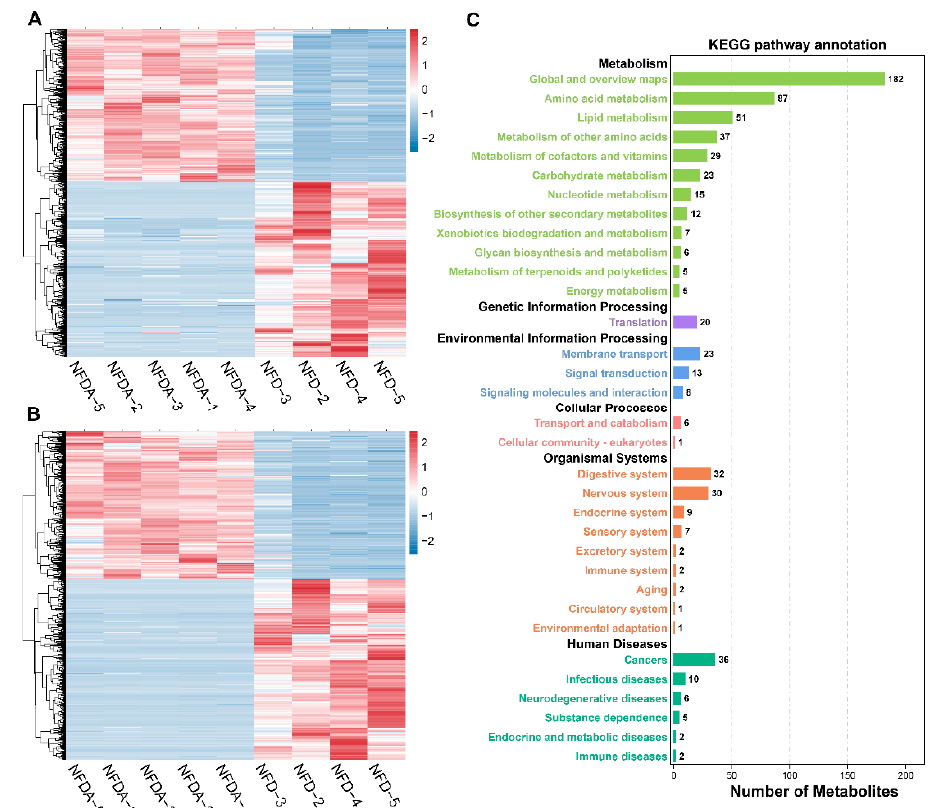
Figure 5. Identification and functional annotation of differential metabolites. ( A ) Clustering heatmap of differential metabolites in positive ion mode. ( B ) Clustering heatmap of differential metabolites in negative ion mode. The red, white and blue colours represent relative abundance from high to low. ( C ) KEGG pathway annotation of differential metabolites. NFD ( n = 4), NFDA ( n = 5).